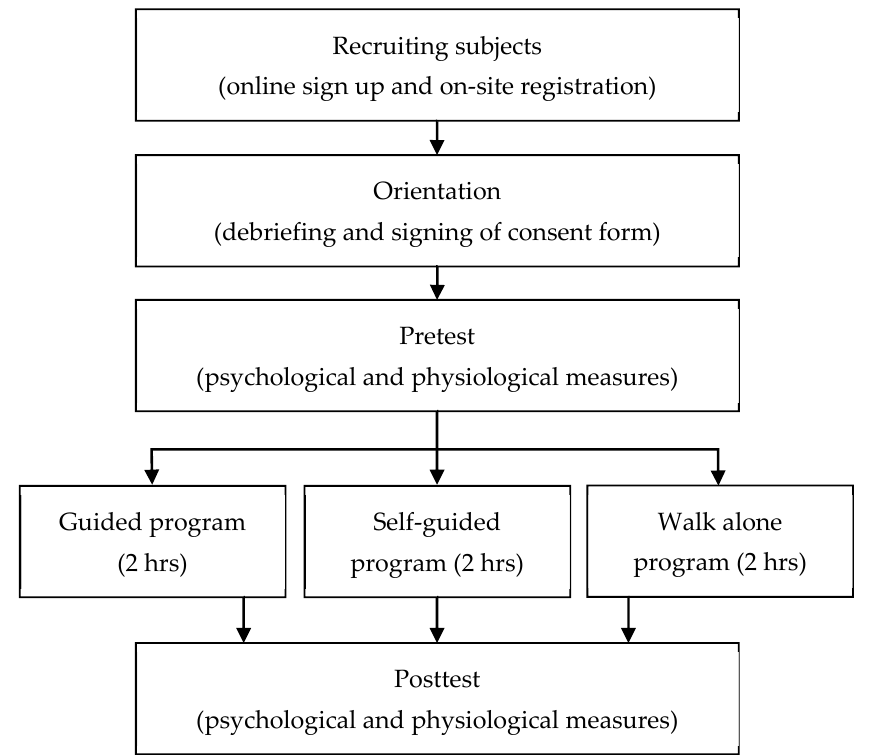
Figure 2. Experimental procedure.